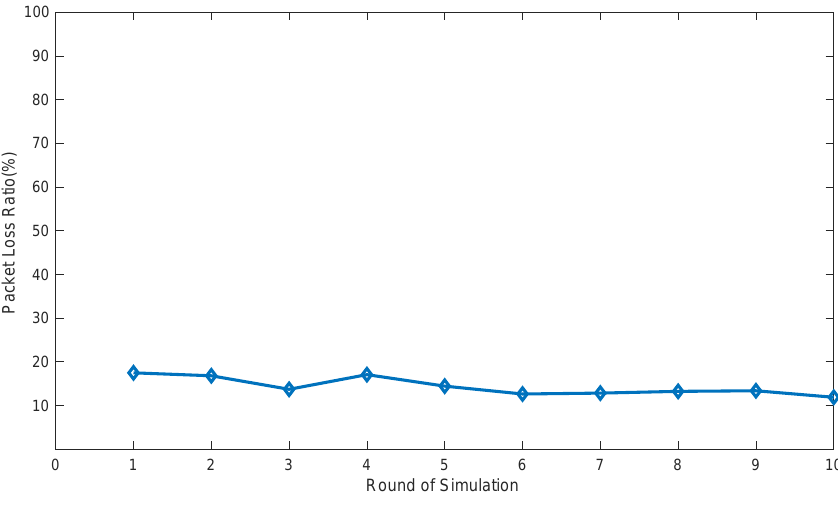
Figure 12. Packet loss ratios in ten independent